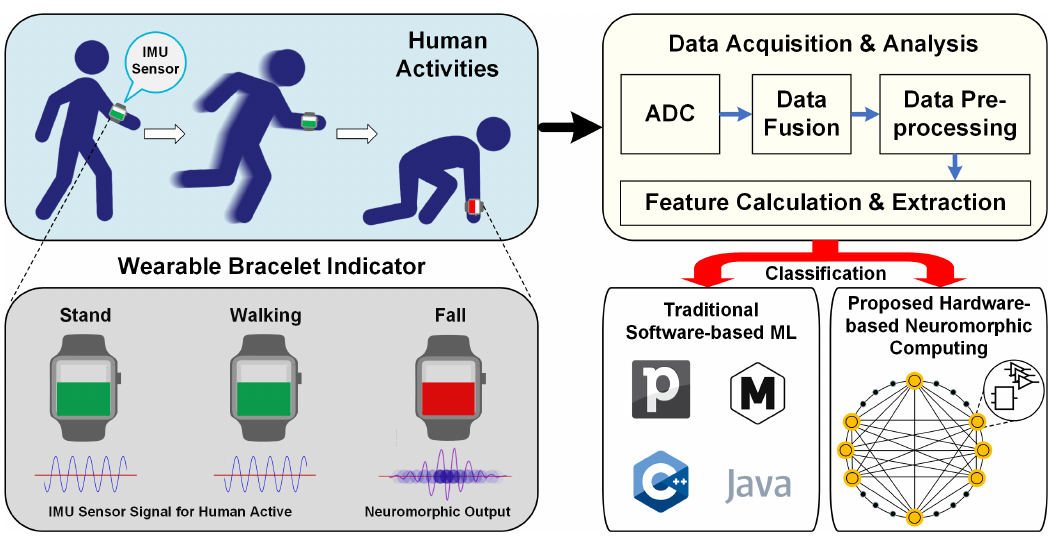
Figure 1. System Workflow from human activities to fall